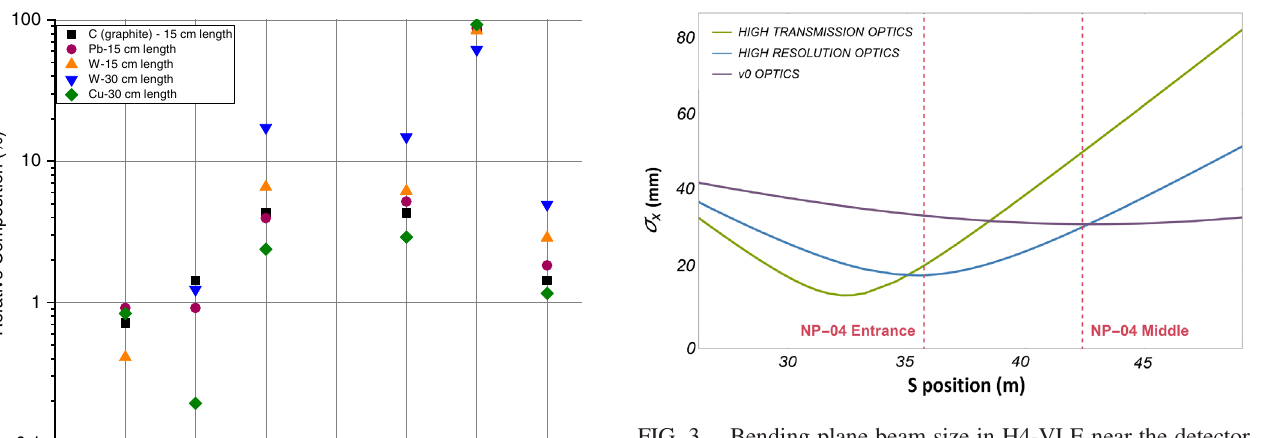
Fig. 4 for the nonbending plane.